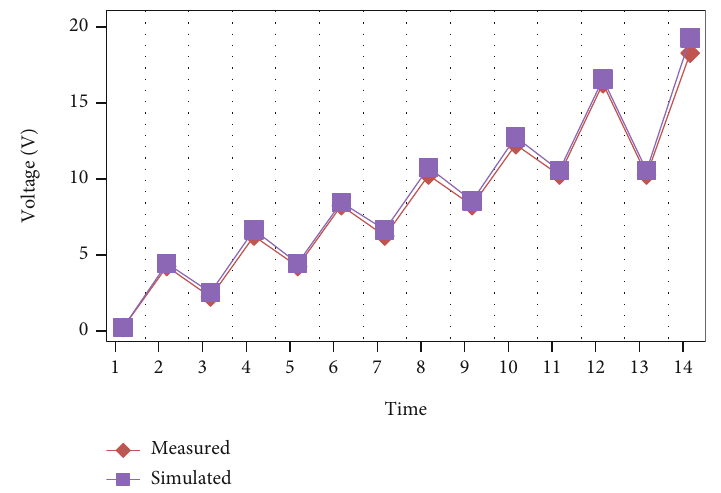
Figure 5: Yuasa NP18-12 battery, 0.2 pulse